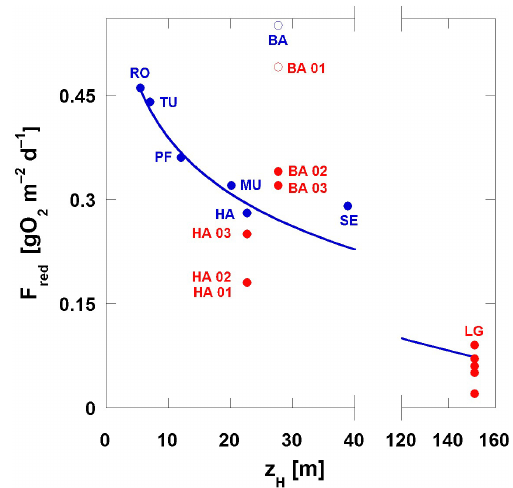
Figure 3. Average fluxes of reduced compounds from the sediments of eight meso- to eutrophic lakes decrease systematically with mean hypolimnion depth ( z H ) , except for sediments sampled at the deep- est sites of lakes with pronounced sediment focusing (BA, BA 01, open circles). F red values of Lake Baldegg (BA01 to 03) show a significant increase with sampling depth due to strong sediment fo- cusing. Blue circles indicate data for Rotsee (RO), Türlersee (TU), Pfäffikersee (PF), Lake Murten (MU), and Lake Sempach (SE), taken from Müller et al. (2012a), while red circles show data of the current study. Meromictic Lake Zug is not shown. The blue line is used to guide the